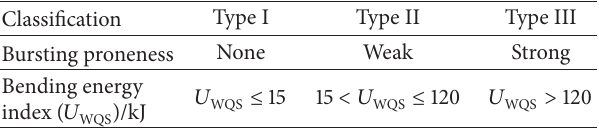
Table 1: Classification of bursting proneness of